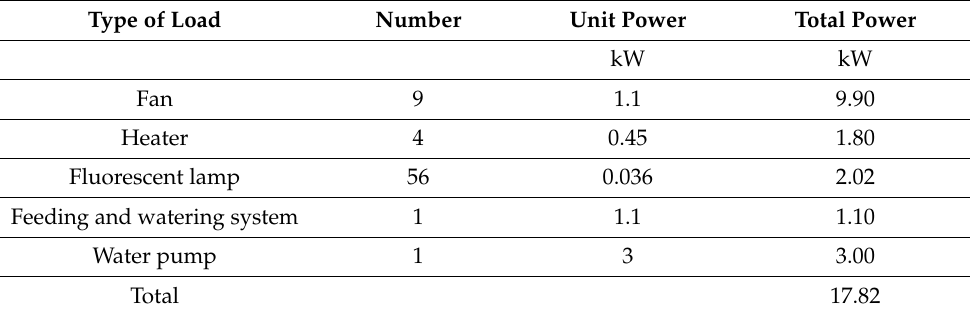
Figure 1. View of the surveyed poultry house. Table 3. Main receivers in the surveyed